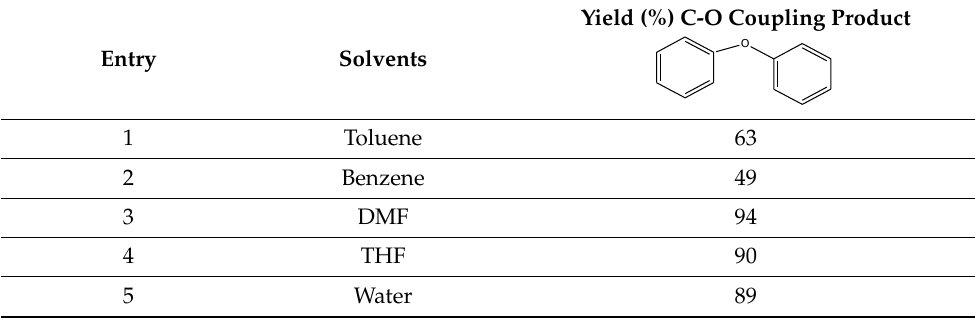
Table 2. The effect of different solvents on the yield for the C-O Ullmann coupling reaction using 5